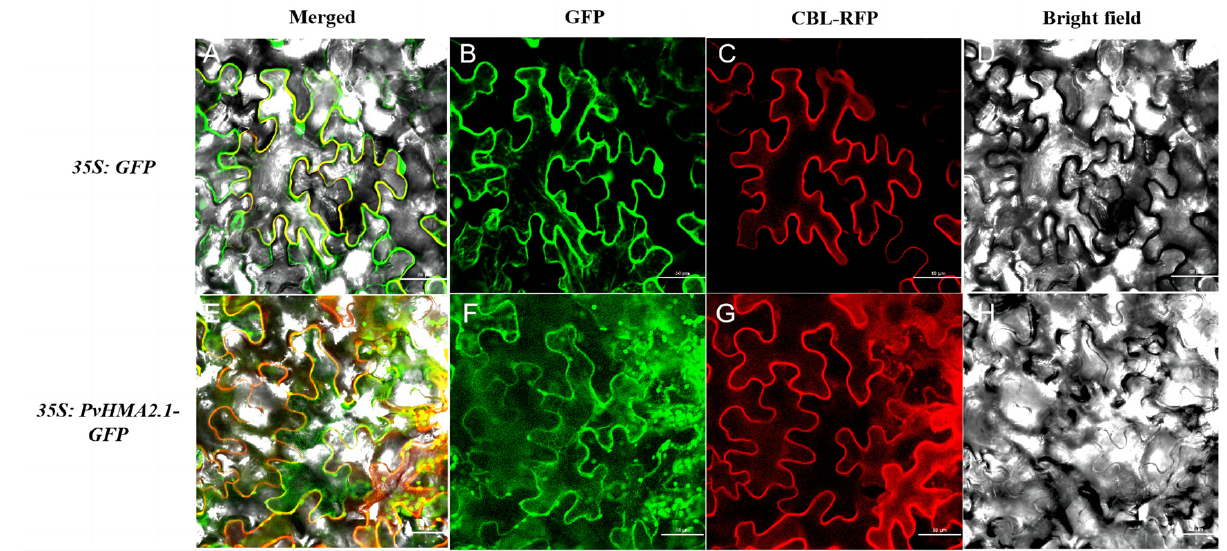
Figure 4. Subcellular localization of PvHMA2.1 in tobacco leaf cell. ( A ) The merger of GFP protein green fluorescence, the cell plasma membrane marker (CBL) protein red fluorescence, and the bright field. ( B ) The green fluorescence of GFP protein. ( E ) The merger of PvHMA2.1-GFP fusion protein green fluorescence, the cell plasma membrane marker (CBL) protein red fluorescence, and the bright field. ( F ) The green fluorescence of PvHMA2.1-GFP fusion protein. ( C , G ) The red fluorescence of cell plasma membrane marker (CBL) protein. ( D , H ) Bright field. Scale bars are 50 µm.